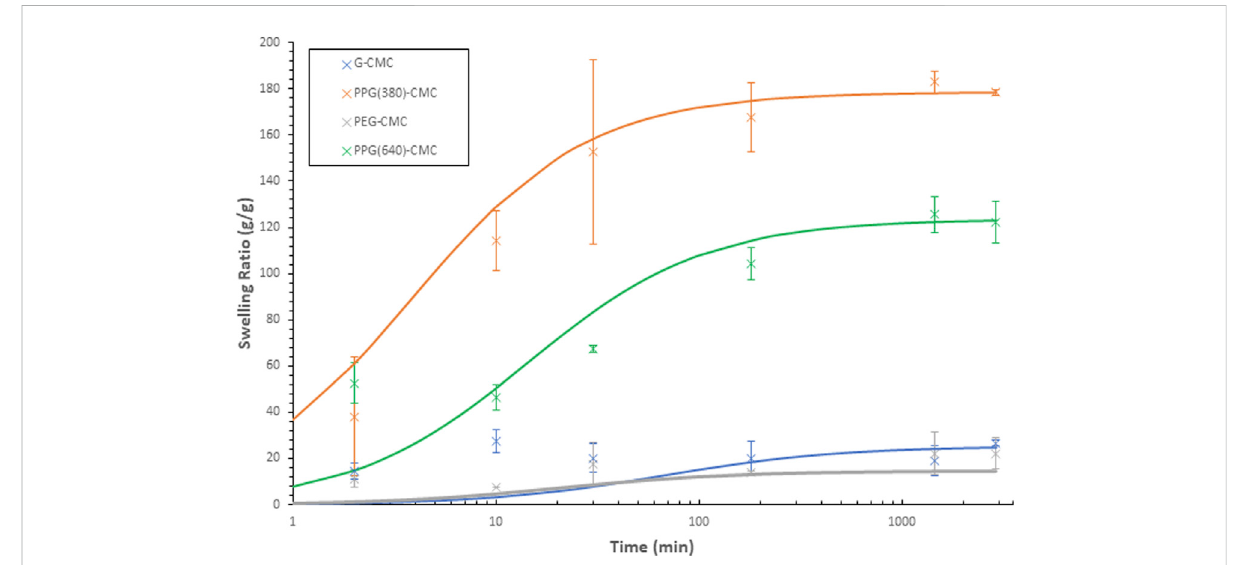
FIGURE 7 Swelling ratio of 0.07 mol/mol CMC-DE materials in deionised water over